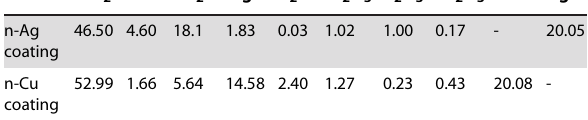
Table 1. Chemical composition of glass-nAg (20wt%) and glass-nCu (20wt%) coatings.